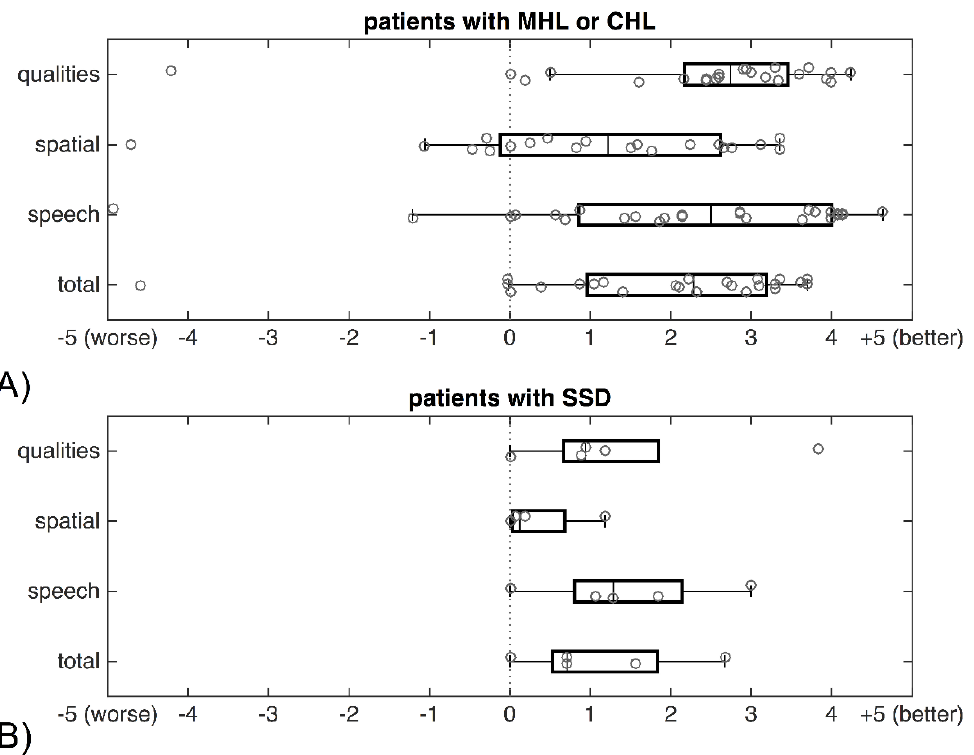
Figure 5. Modified SSQ questionnaire total score and subscores for ( A ) CHL/MHL patients (N = 24) and ( B ) patients suffering from SSD (N = 5). Grey circles depict individual data. The value “0” on the x -axis represents no difference compared with the situation prior to implantation. Positive values indicate subjective improvement; negative values indicate deterioration of the hearing situation.